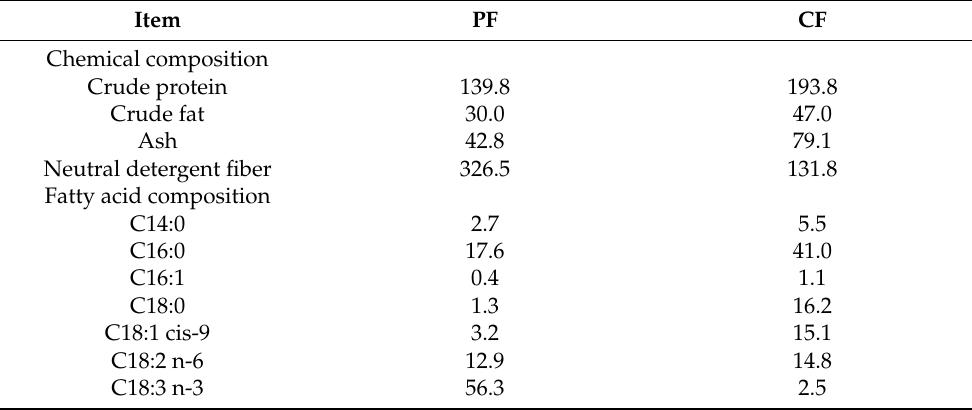
Table 1. Chemical composition (g kg − 1 dry matter) and fatty acid composition of the diets at different feeding